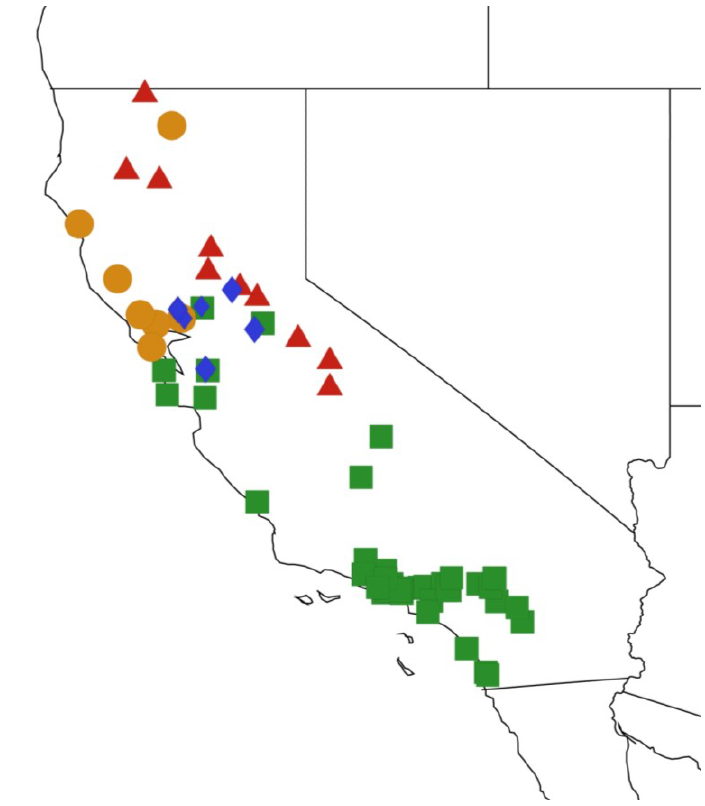
Figure 42. Distribution of Platypedia laticapitata (green squares), P. intermedia (orange circles), P. middlekauffi (red triangles), and P. usingeri (blue